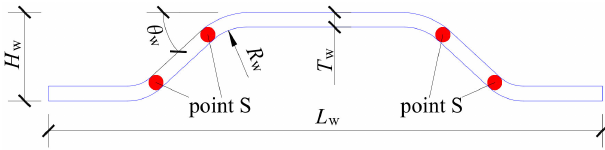
Figure 4. Key geometric parameters of corrugated steel web.